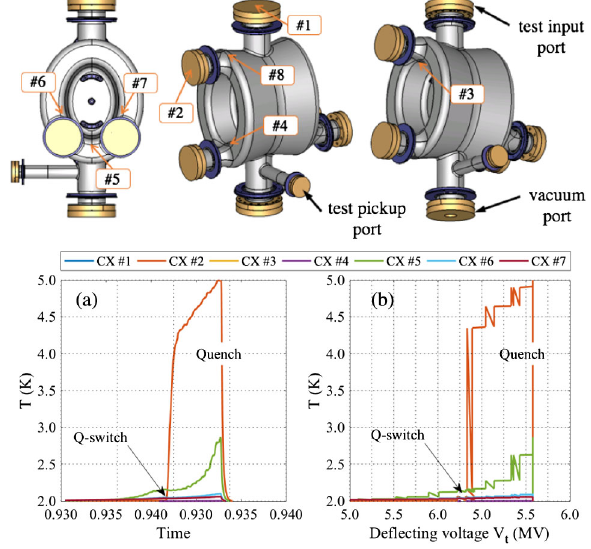
FIG. 12. (Above) Temperature sensors locations for a cold test of cavity 1 and a first cold test of cavity 2. (Below) Signal recorded from temperature sensors 1 – 7 during a cold test of cavity 1: (a) temperature versus time; (b) temperature versus deflecting